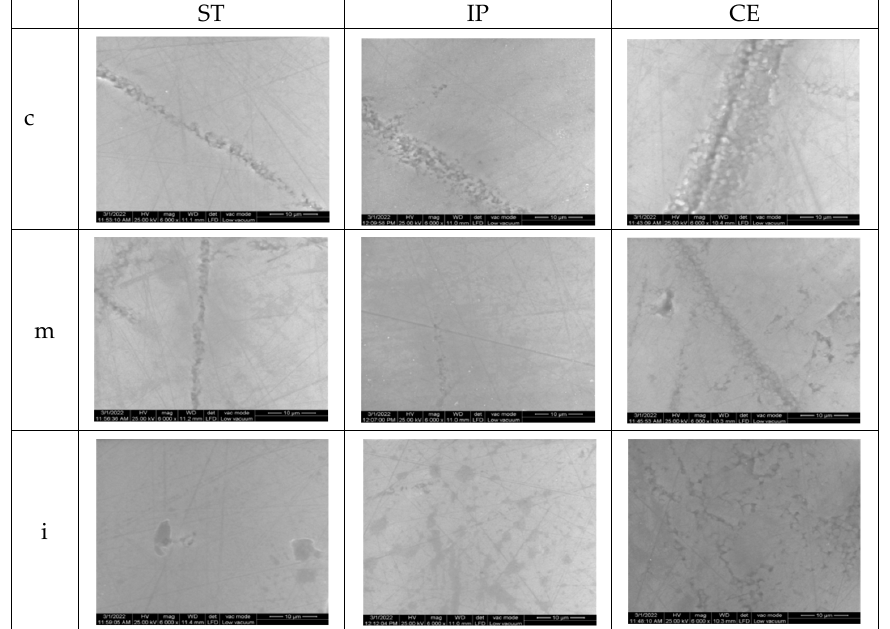
Figure 10. SEM images for polished samples after aging.ST = STML, IP = IPS e.maxZirCAD CEREC/in Lab MT Multi, CE = CeramillZolidfx ML, c = cervical, m = medium, i = incisal.